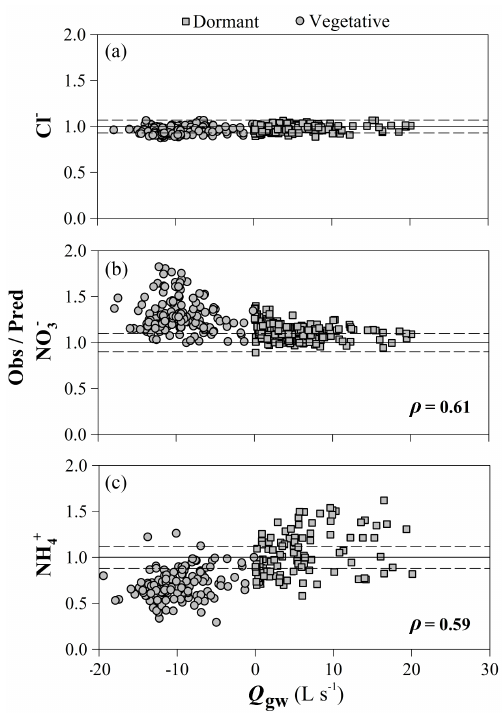
Figure 5. Relationship between mean daily net groundwater in- puts ( Q gw ) and the ratio between stream concentrations observed at the bottom of the valley reach (downstream site) and those predicted from hydrological mixing for (a) chloride, (b) nitrate and (c) ammo- nium. Data are shown separately for the vegetative (circles) and dor- mant (squares) period. The Spearman coefficient is shown in each case. The solid line indicates no differences between observed and predicted concentrations, and the dashed lines indicate the uncer- tainty associated with the zero line as explained in the material and methods